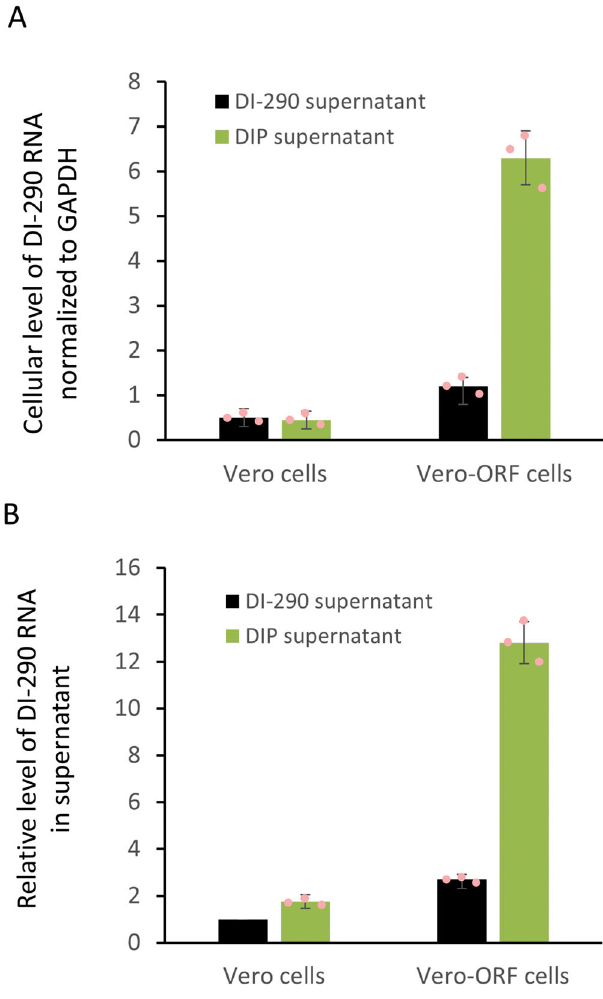
Fig. 5 DIPs and their DI-290 RNA are a transmissible VLP. Vero cells or Vero-ORF expressing DENV-2 S and NS proteins were treated with cell-free culture supernatant of HEK-DI-290 (black bars, a negative control) or DIP supernatant of HEK-DI-290-ORF cells (red bars) for 12 h when the culture medium was replaced. After 48 h, RNA samples were prepared from A cells and B culture supernatant and used in RT-qPCR assays to measure levels of DI-290 RNA. The cellular levels of DI-290 were normalized to GAPDH mRNA in the same sample. The relative level of DI-290 in Vero cells treated with negative control supernatant was set as 1. The error bars indicate the SD. A representative of three experiments with similar results is shown.